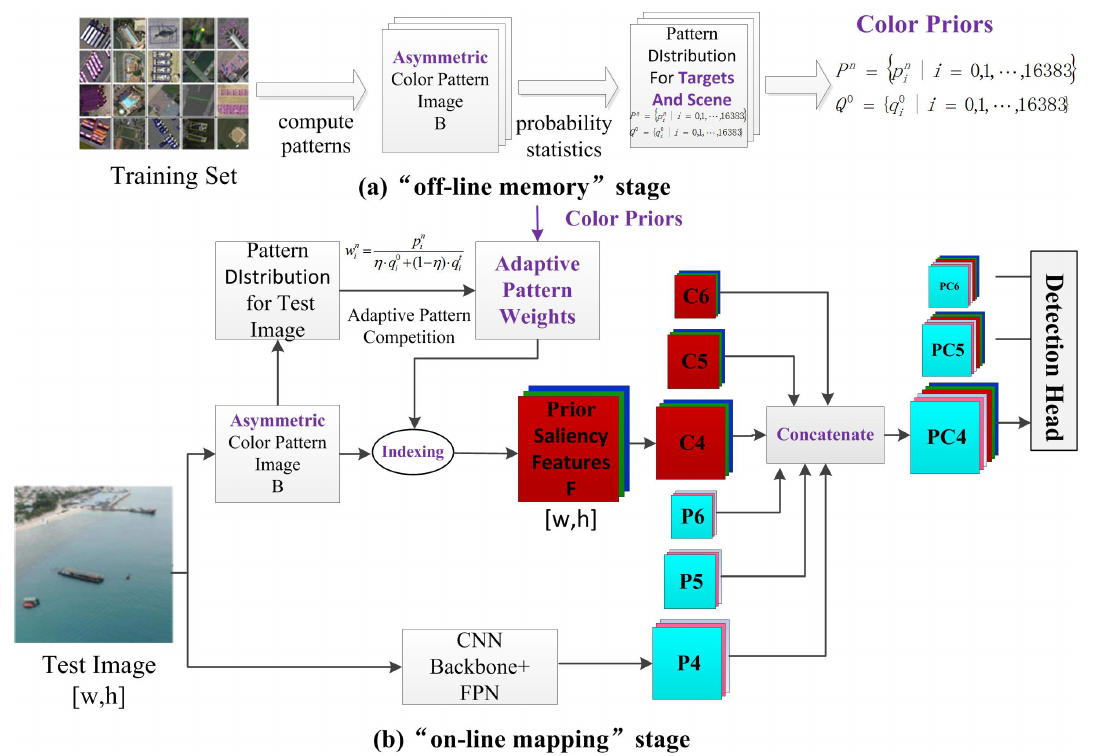
Figure 1. Overall architecture of object detection method combined with color prior